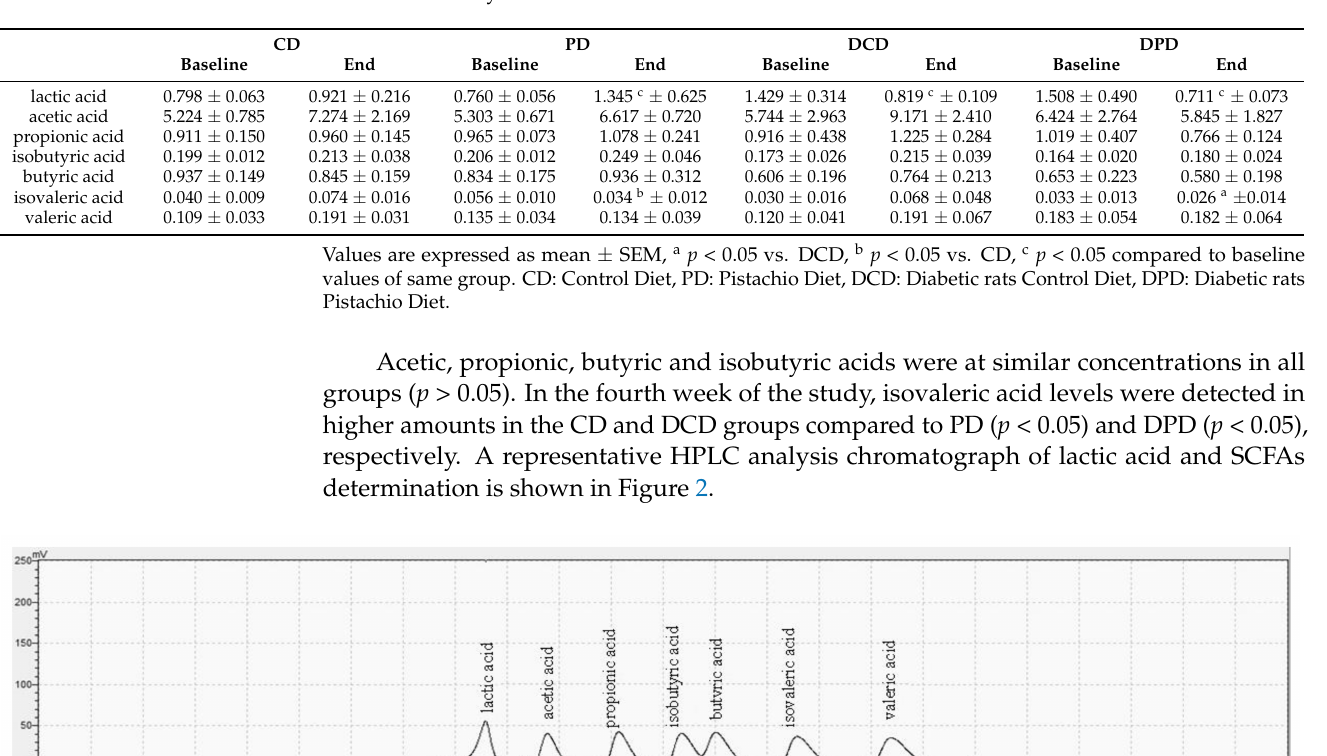
Table 3. Fecal short-chain fatty acids (SCFAs) in the four groups of animals, at baseline and at the end of the dietary intervention.